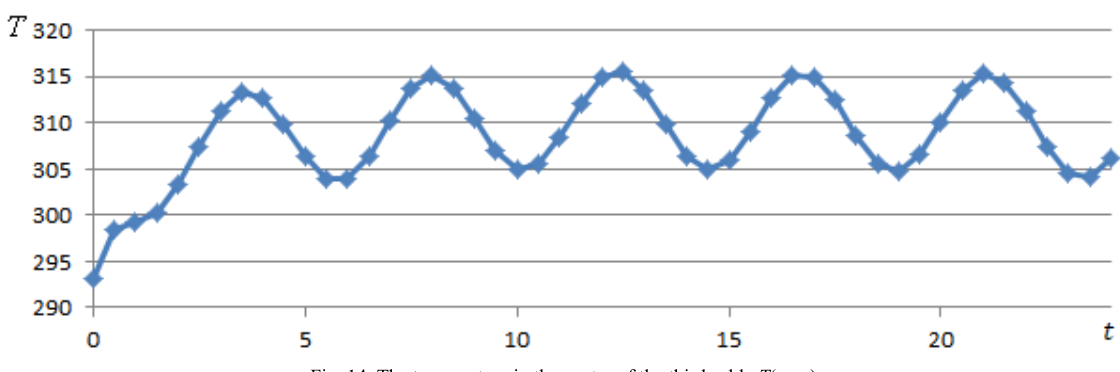
Fig. 13. The temperature in the centre of the second cable T ( x C2 , t ).